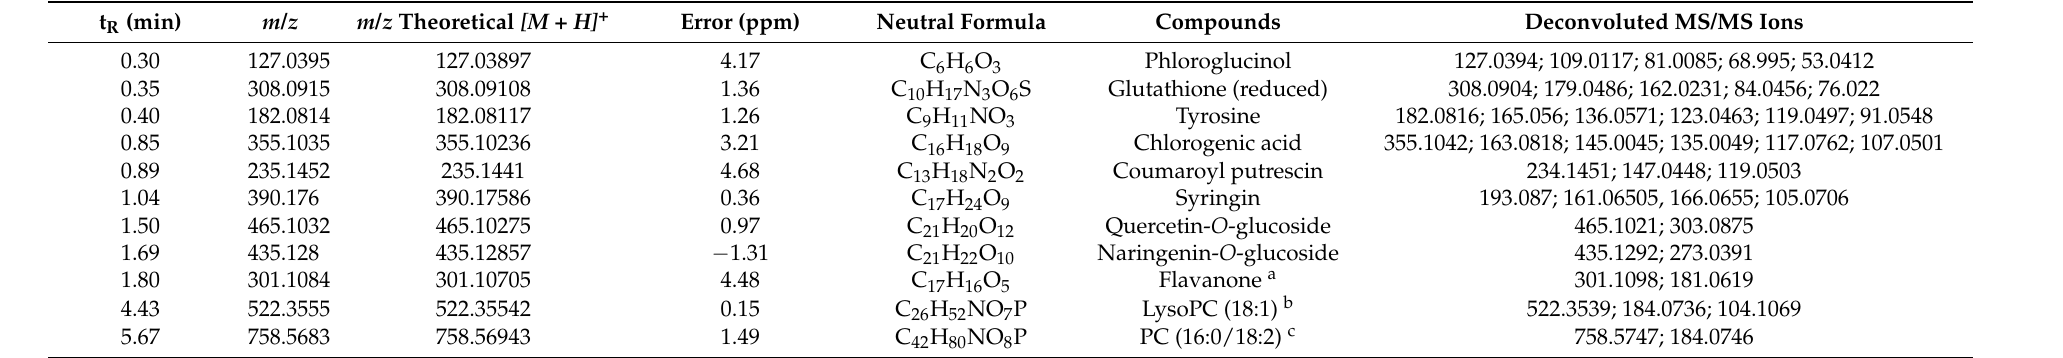
Table 2. Other V. album ssp. album compounds putatively